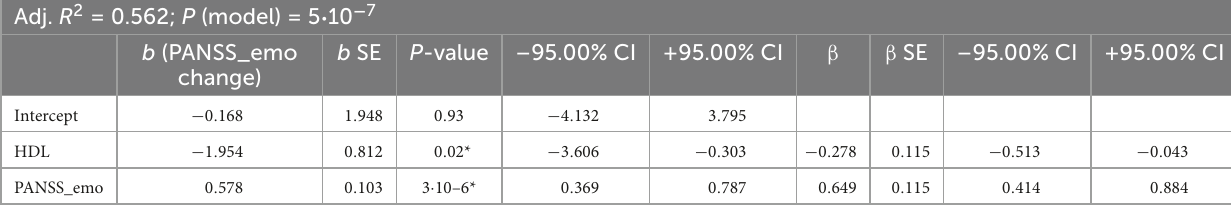
TABLE 2e Results of stepwise linear regression analyses for subscales of the Positive and Negative Syndrome